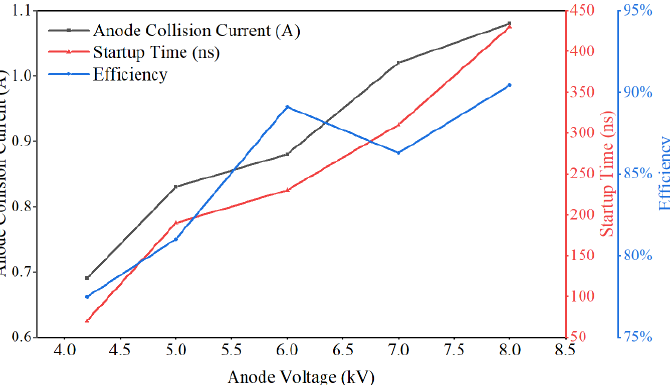
Figure 7. Different anode voltages and magnetic fields taken from the π -mode line were used to calculate the anode collision current, oscillation time, and electron efficiency.